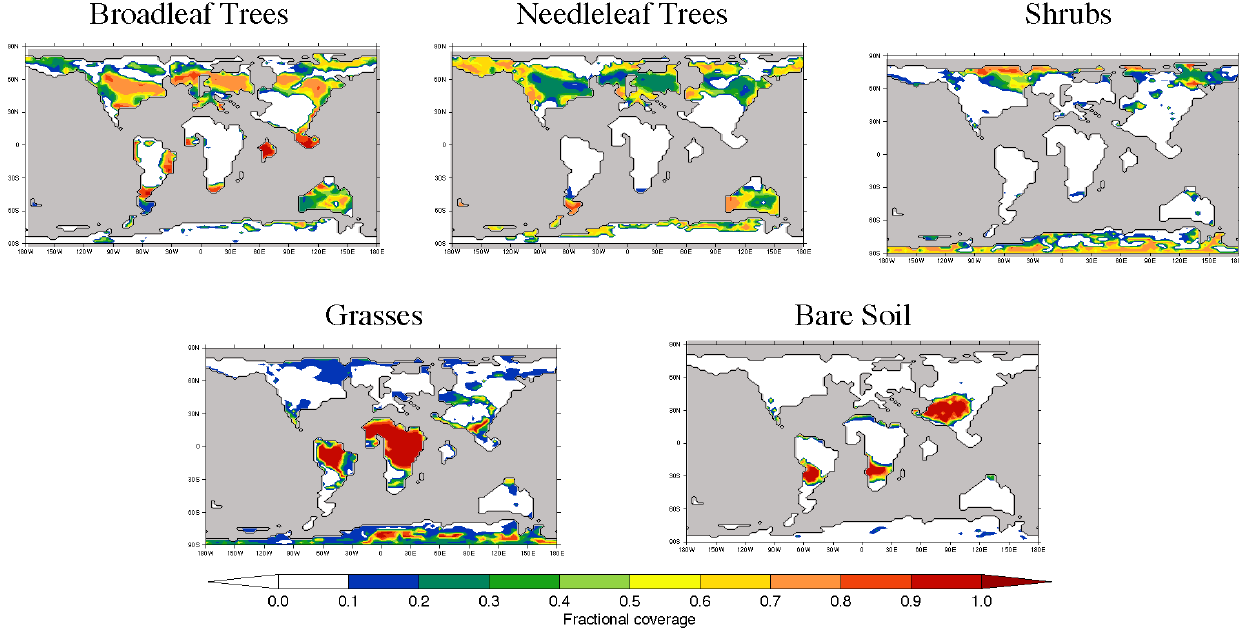
Fig. 1. Global early Eocene vegetation distributions for 2 × DYN as predicted by TRIFFID.